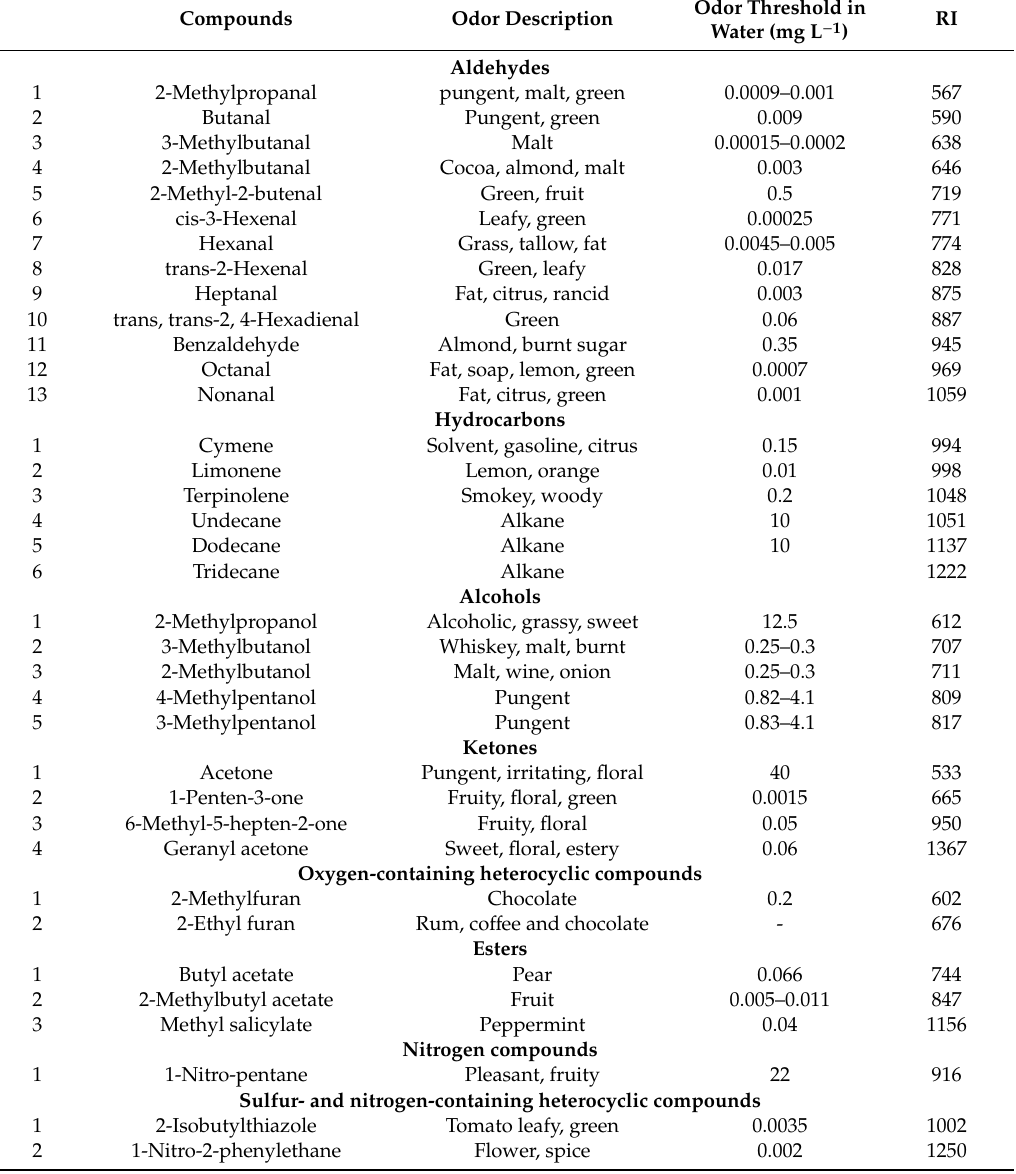
Table 2. Identification of volatile compounds identified in tomato fruits, along with their odor descriptions, odor thresholds in water, and RI